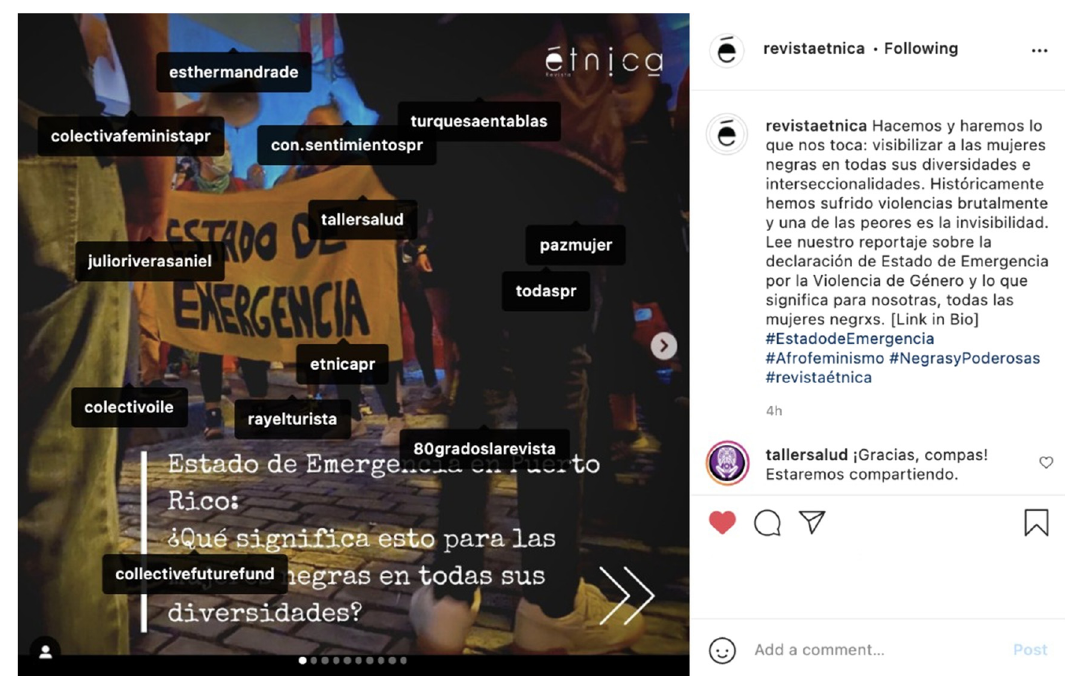
Figure 2: Screenshot from Revista Étnica Instagram